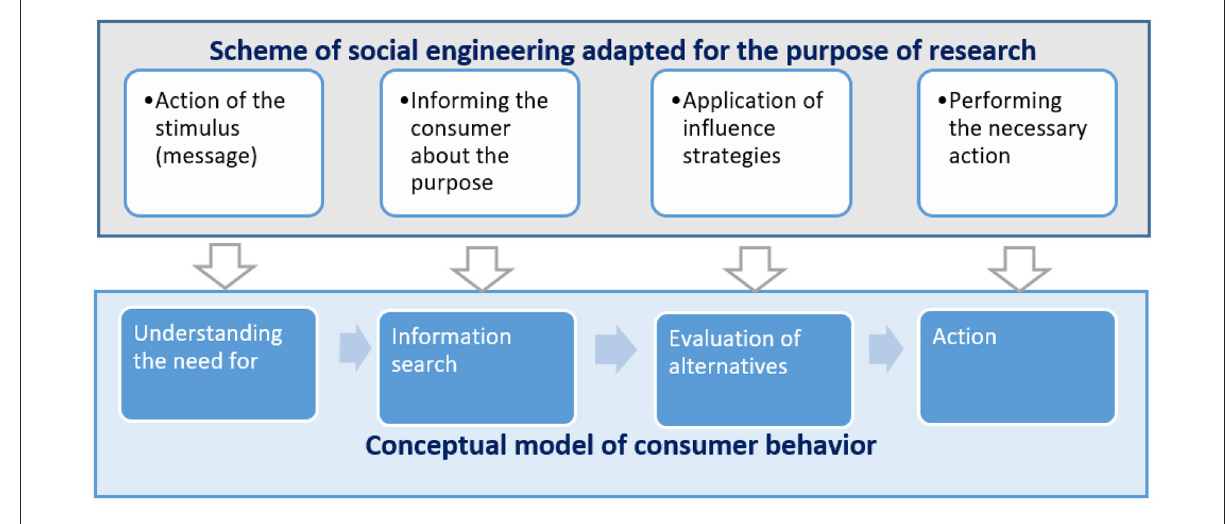
FIGURE6 Scheme of influence on consumer behavior by methods of social engineering. Source: Researchers’ elaboration based on research data.